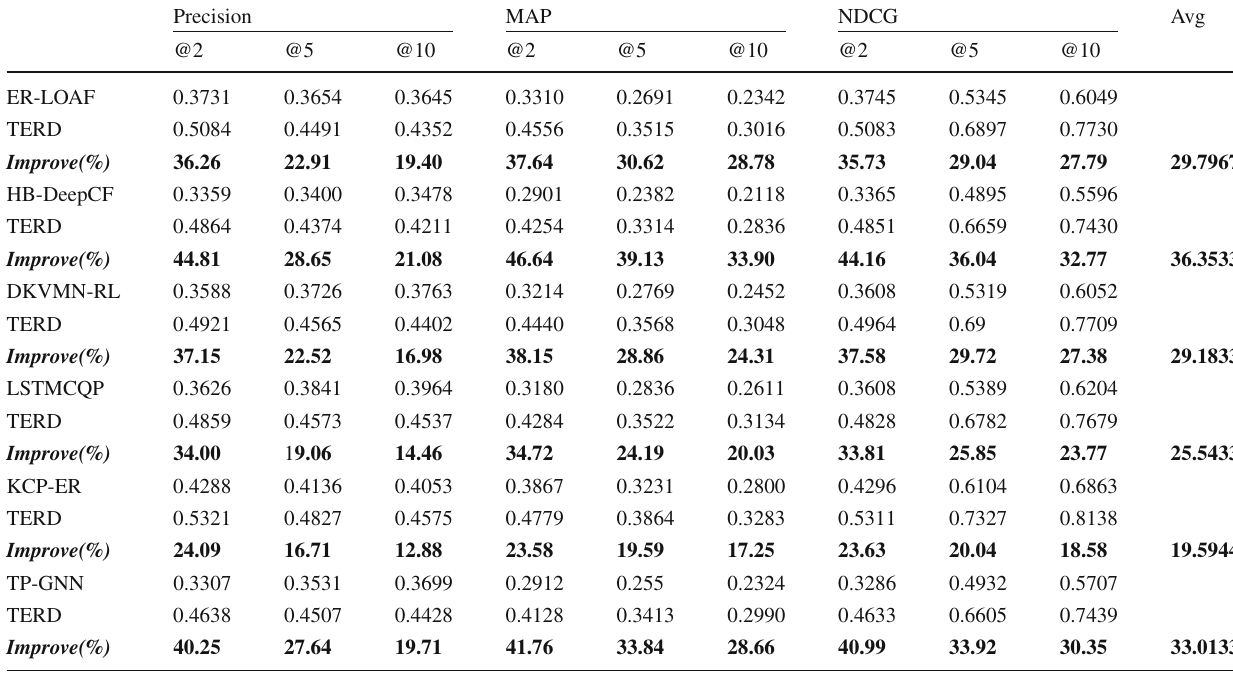
Table 3 Results of comparison among six algorithms with and without adding teacher network on ASSISTments0910 dataset Precision MAP NDCG